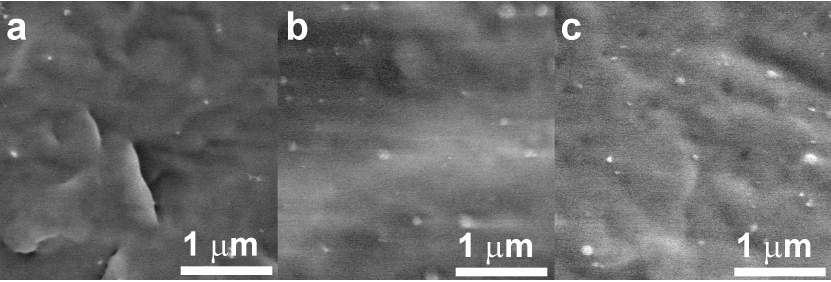
Figure 3. SEM microphotographs of fracture surfaces of polymer nanocomposites with Ag-ZnO particles: ( a ) PP100/Ag-ZnO5; ( b ) PP75/Ag-ZnO5; ( c ) PP50/Ag-ZnO5.